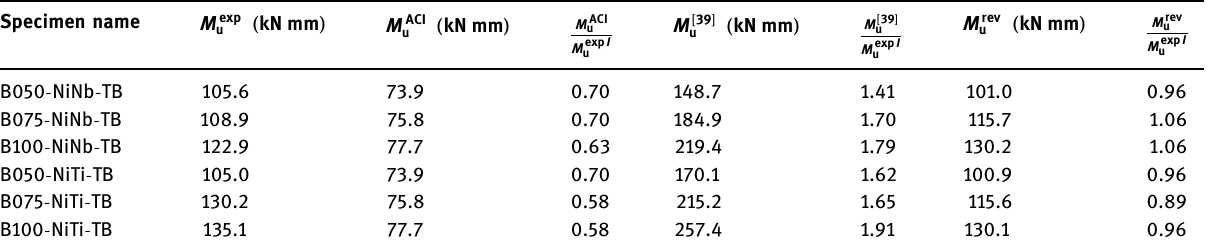
Table 3: Comparisons of the mean ultimate fl exural moment of the SMA fi ber – embedded beams with tensile wires Specimen